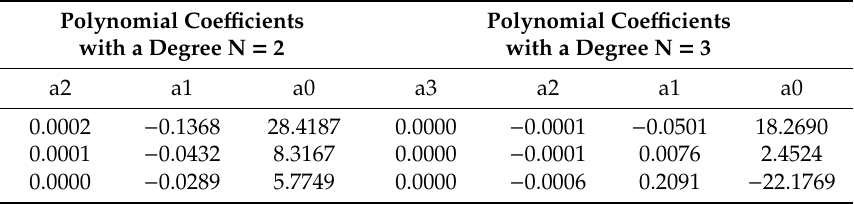
Table 3. Polynomial coe ffi cients with the degree N = 2 and N = 3 for selected incorrect drives (i.e., drives outside the designated driving